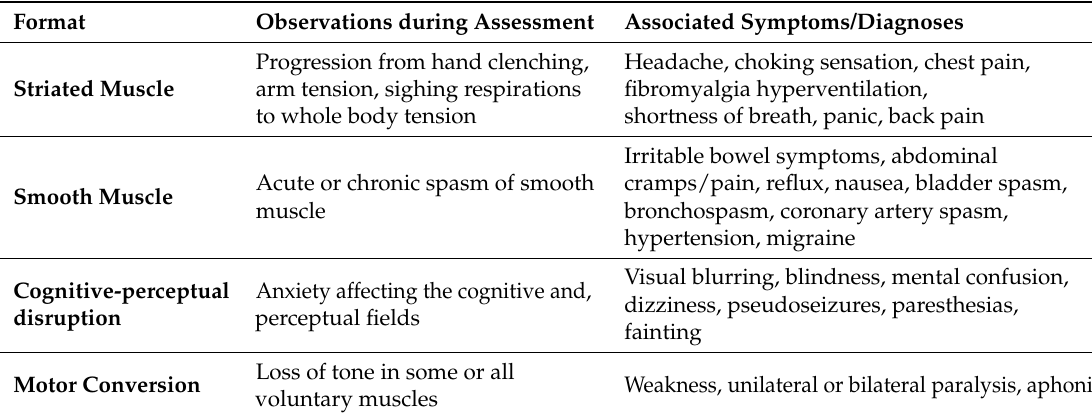
Table 1. Bodily Patterns of Medically Unexplained